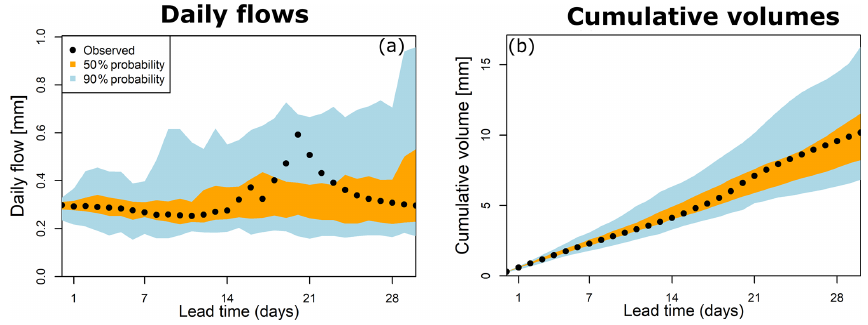
Figure 4. Time series of daily and cumulative probabilistic forecasts from the seamless MuTHRE model for the Murray River at Biggara (401012; see Fig. 3) for May 2002. The non-seamless monthly QPP model does not have the capability to produce these forecasts.